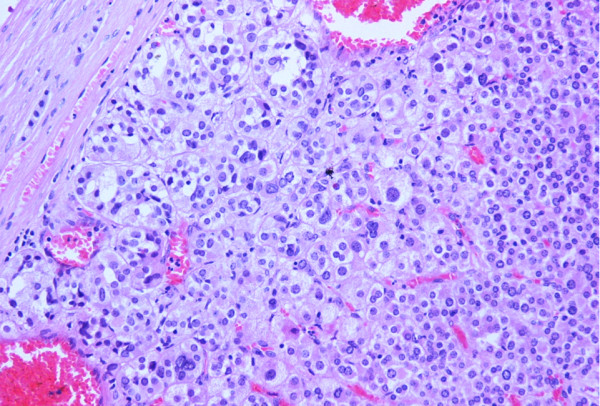
Histological section (H&E counterstain) of the adrenocortical neoplasm in the left adrenal gland, depicting cells with moderate to marked nuclear pleomorphism (magnification X200).